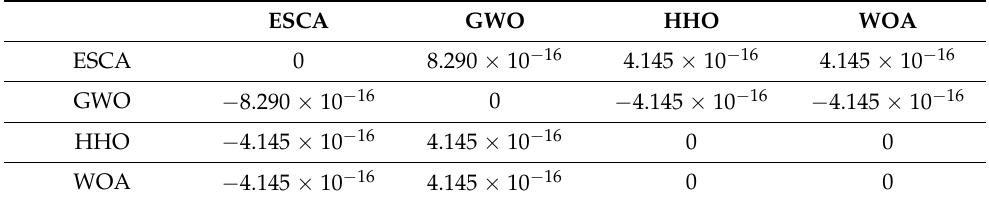
Table 22. Comparison of solution accuracy for the assessed algorithms. Contrast Estimation based on medians.